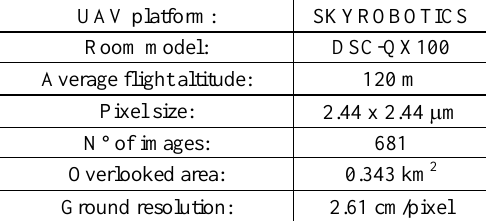
Table 1. Characteristics of the flight mission